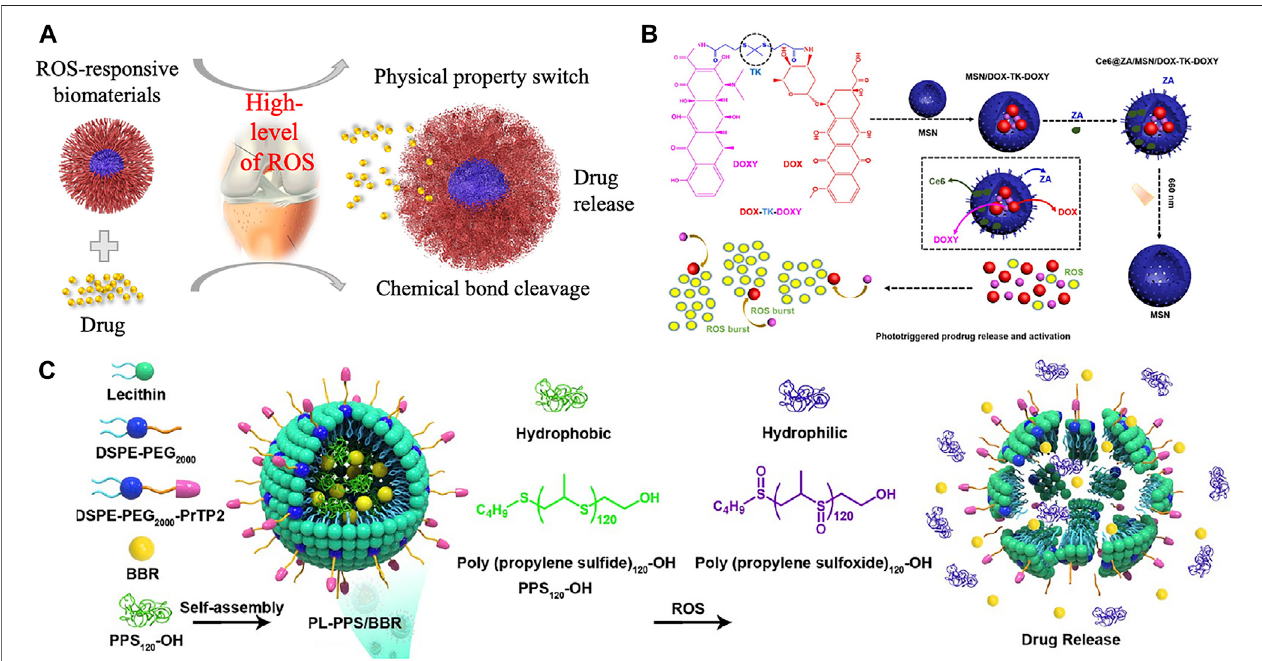
FIGURE 2 | (A) . Scheme of ROS-responsive drug-loaded biomaterials and its responsive mechanism for the treatment of bone-related diseases. (B) . Prodrug DOX-TK-DOXY was loaded into the mesoporous silica nanoparticles (MSNs) and disrupt the TK linkage of the prodrug in an ROS environment. Reproduced